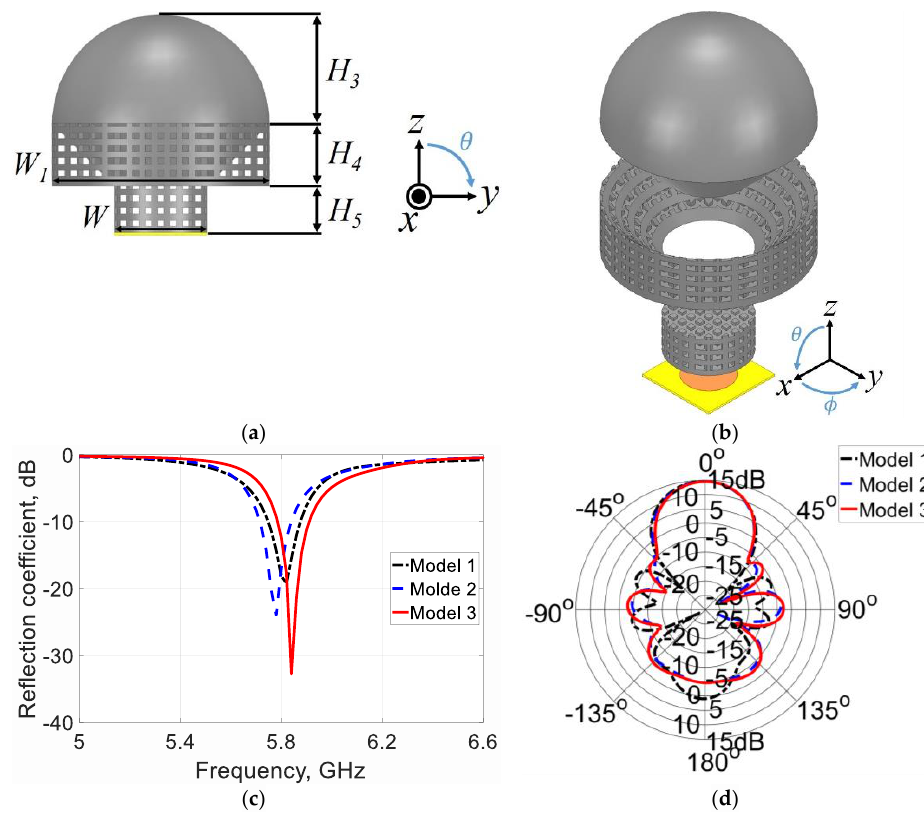
Figure 6. Proposed design (model 3). ( a ) Simulation model. ( b ) Perspective view of the proposed design. ( c ) Reflection coefficient. ( d ) 𝜃 -sweep radiation pattern ( 𝜙 = 0° ).